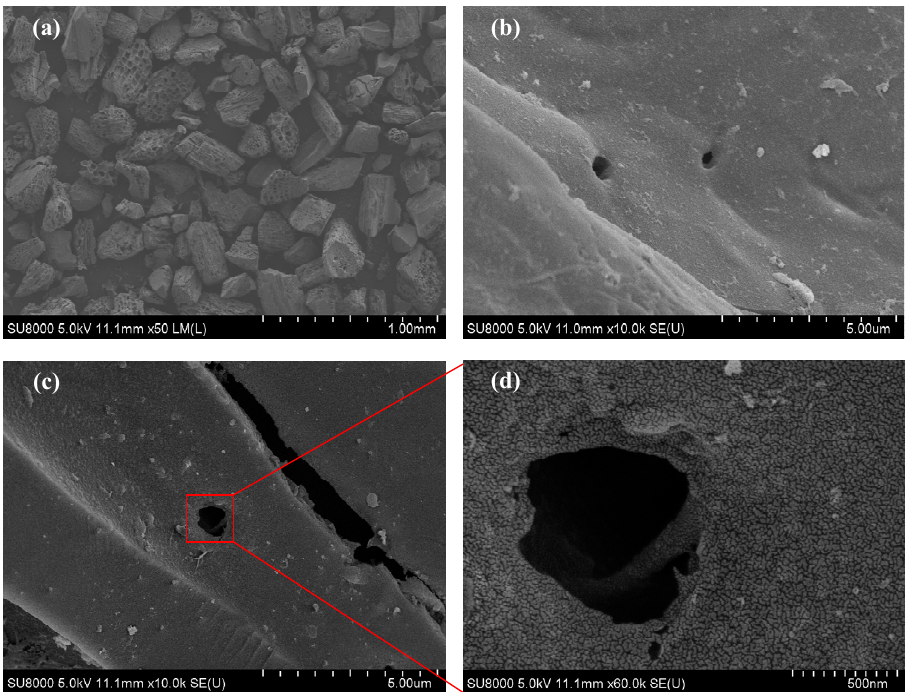
Figure 2. SEM patterns of bamboo charcoal ( a , b ) and N-doped bamboo-based activated carbon ( c , d ).